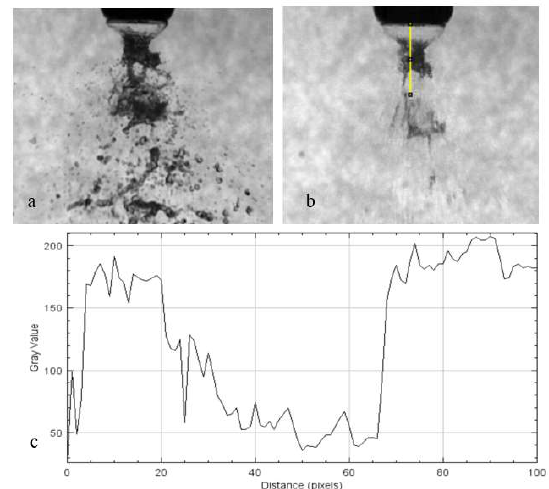
Figure 12. Breakup length measurement: ( a ) contrast-enhanced raw image, ( b ) maximum intensity (averaged) image, and ( c ) profile of grayscale values along the centerline (yellow).